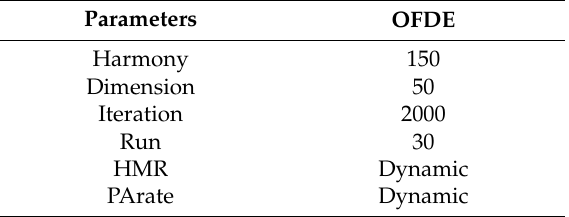
Table 11. Parameters used in the experiment for the OFHS